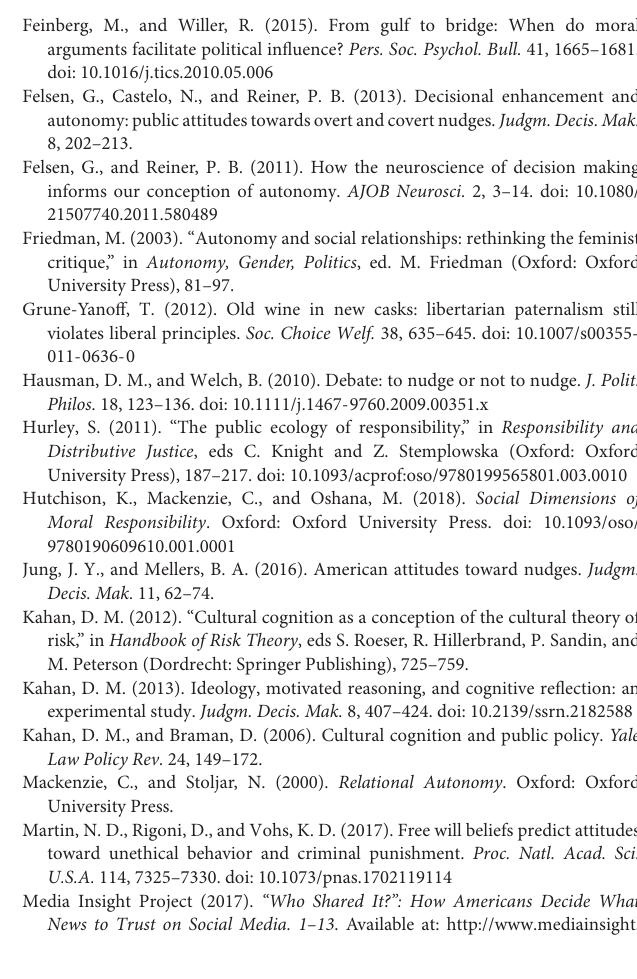
FIGURE S1 | Full set of screens presented to the respondents. DATA SHEET S1 | Excel file containing all data included in this